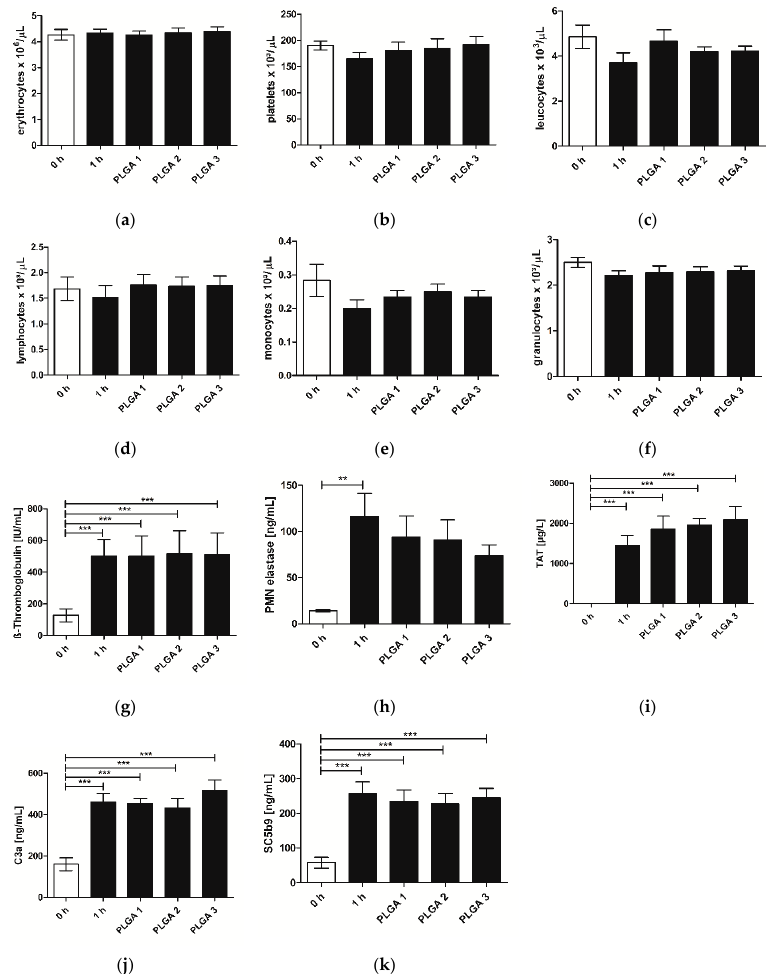
Figure 3. Hemocompatibility of PLGA 1–3–coated slides. Slides were incubated with fresh human blood at 37 ◦ C for 1 h under gentle shaking. The 0 h control was fresh blood without incubation and served as a baseline. Different blood cells, inflammatory and